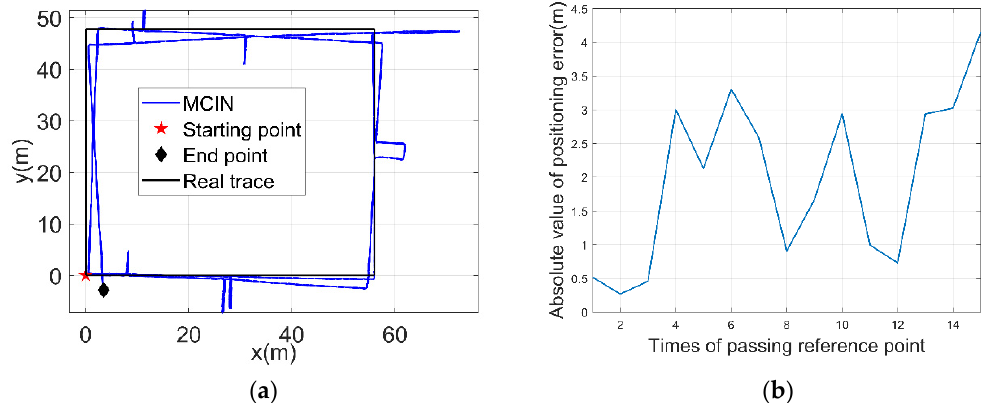
Figure 14. Two dimensional trace and absolute value of positioning error based on MCIN method. ( a ) Two dimensional trace. ( b ) Absolute value of positioning error.